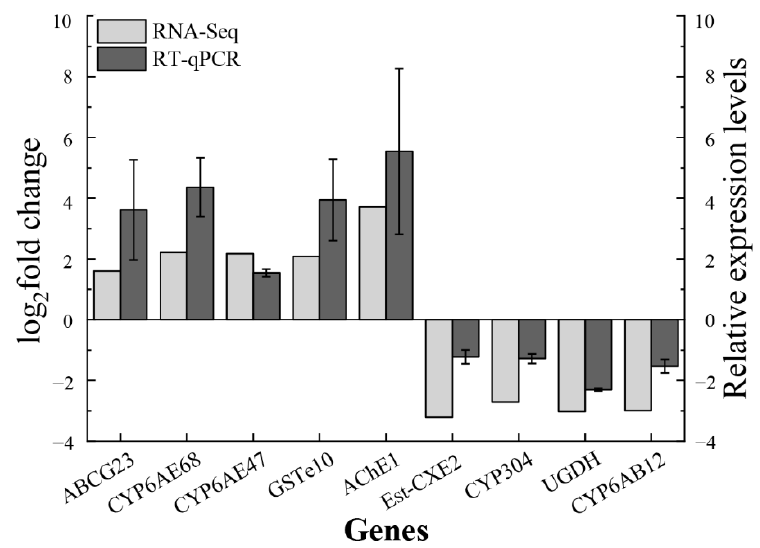
Figure 7. RT-qPCR validation of DGE results. Five upregulated genes and four downregulated genes were identified by RT-qPCR. The left y-axis represents the log 2 fold change by RNA-seq, and the right y-axis represents the relative expression level by RT-qPCR.